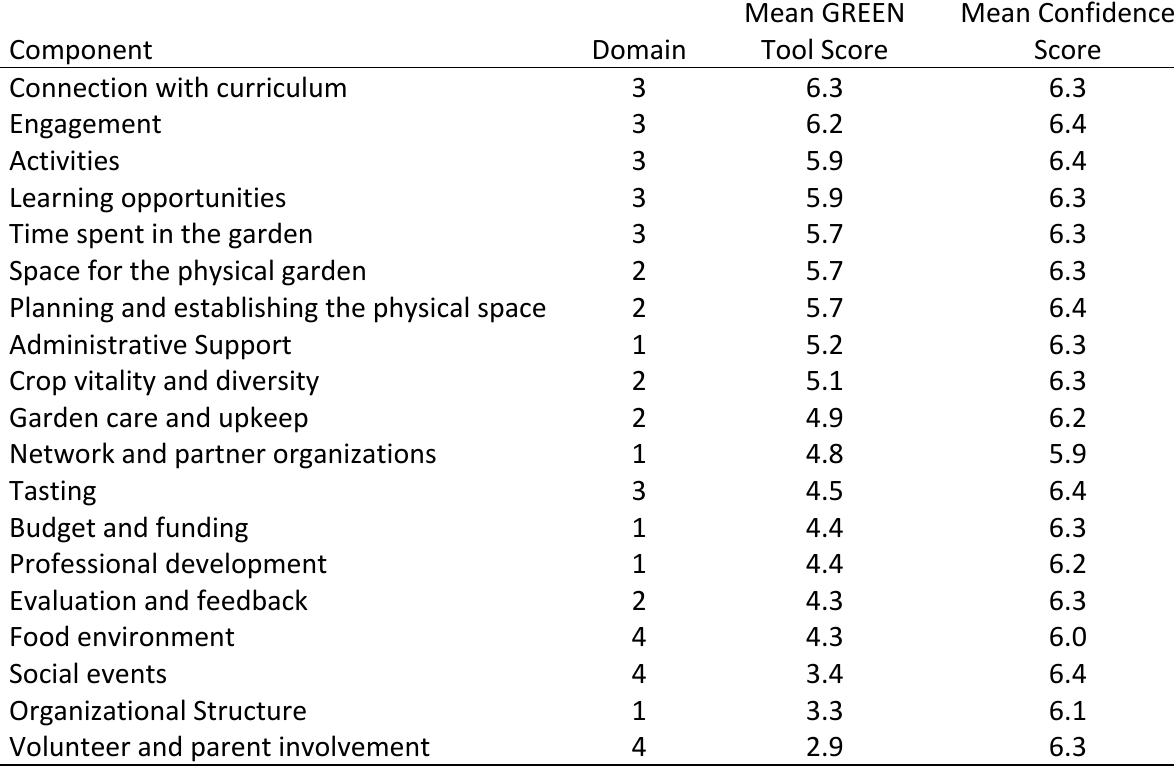
Highest to Lowest Ranked Mean GREEN Tool Scores for all Components (n = 15) Component